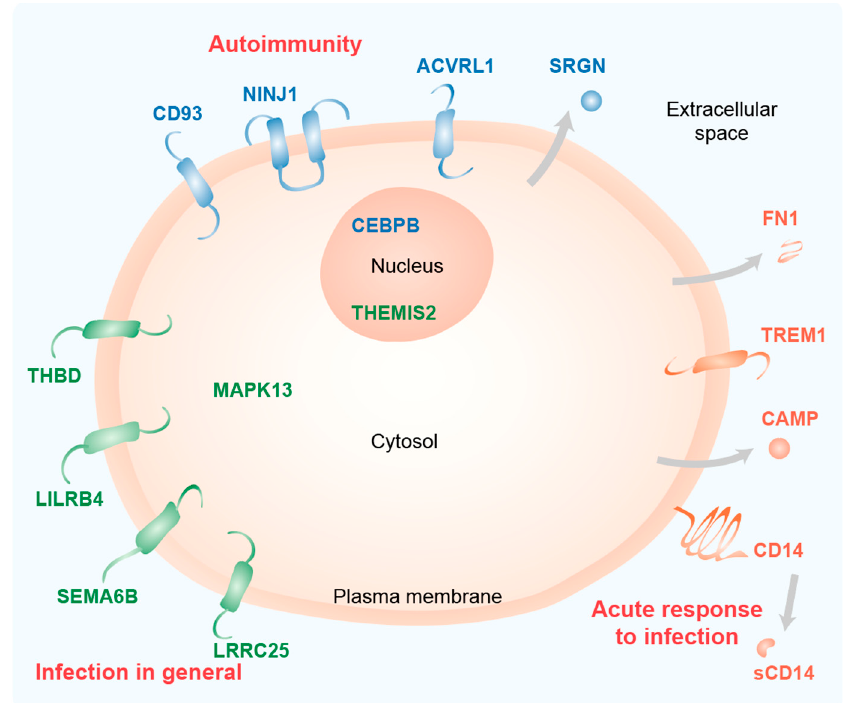
Figure 5. Functional profile of key immune-related vitamin D target genes. Schematic picture of a cell indicating the main location of the proteins encoded by the 15 key genes. The information is based on GeneCards (www.genecards.org) and publications cited in the text. The classification of the proteins (group 1: orange, group 2: green, group 3: blue) is based on their transcriptome profile (Figure 4). The main immune-related function of the protein groups is indicated in red.